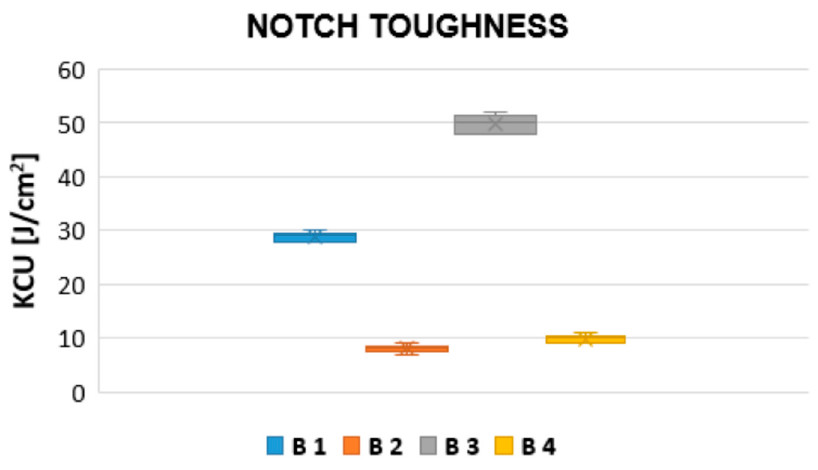
Figure 8. Measured values of notch toughness for individual clad layers.